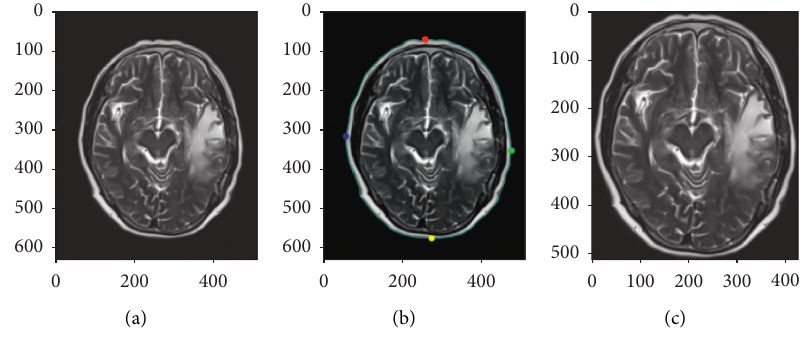
Figure 4: Removal of redundant areas of MRI